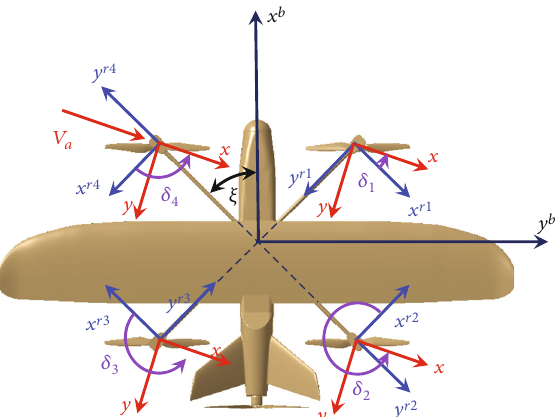
Figure 6: The de fi nition of δ